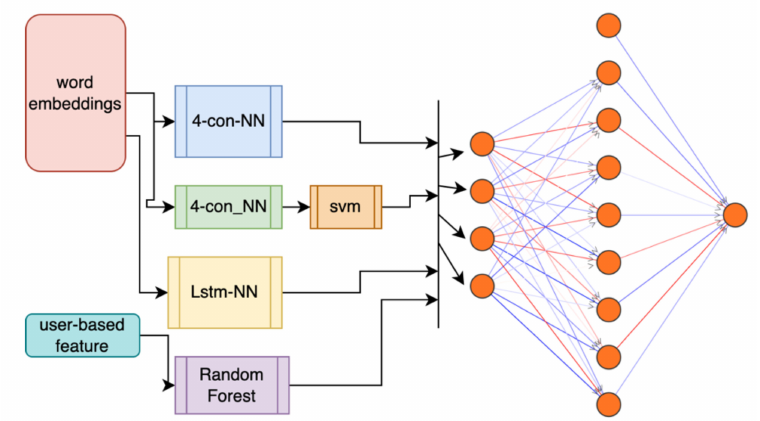
Figure 4. Ensemble neural network